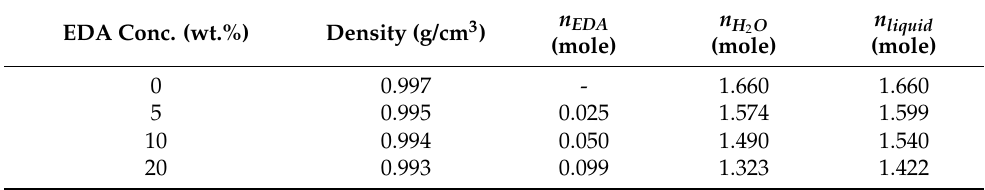
Table A1. Mole numbers in EDA aqueous